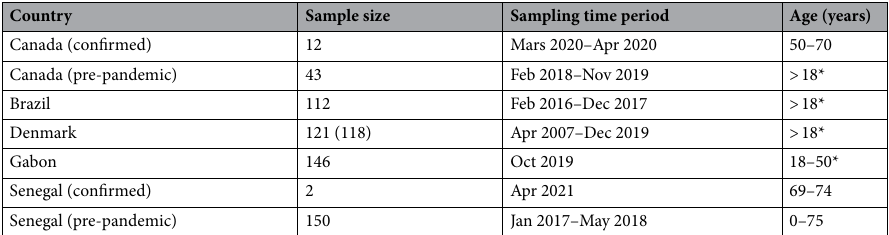
Table 1. Study cohort. The size, collection period and age is indicated for the various samples cohort used in this study. *Codified samples from adult donors (> 18 years old) were obtained. No donors specific information were available as indicated in the respective ethic